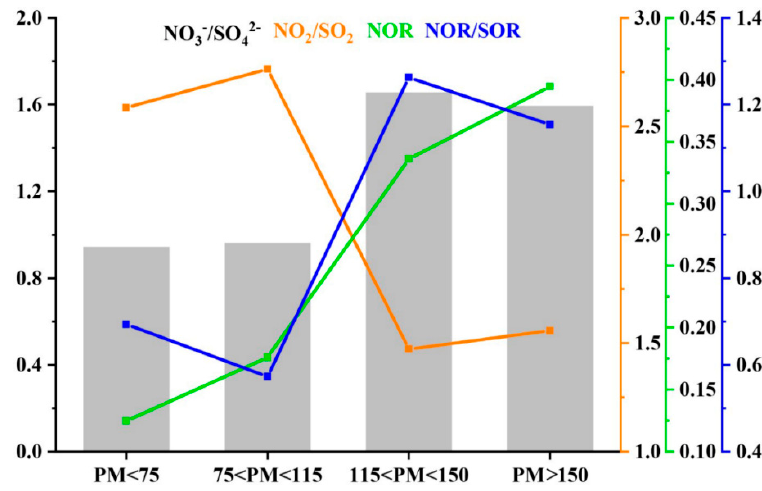
Figure 8. NO 3 − /SO 42 − ratio, NO 2 /SO 2 ratio, NOR and NOR/SOR ratio at different range of PM 2.5. Nitrate is predominantly formed by the homogenous reaction of NO 2 and OH radical during daytime and by heterogeneous hydrolysis of N 2 O 5 at night. Generally, the molar ratio [NH 4+ ]/[SO 42 − ] was used to assess NH 4+ rich conditions. As shown in Figure 9a,c,e, the intercept of [NH 4+ ]/[SO 42 − ] axis in linear regression models was 2.311 during the whole studied period, indicating that nitrate formation by homogeneous reactions of HNO 3 with NH 3 became significant at [NH 4+ ]/[SO 42 − ] > 2.311. Thus, the “excess ammonium” were defined as [NH 4+ ] excess = ([NH 4+ ]/[SO 42 − ] − 2.311) × [SO 42 − ] for the whole studied periods, [NH 4+ ] excess = ([NH 4+ ]/[SO 42 − ]– 3.162) × [SO 42 − ] for haze episodes, and[NH 4+ ] excess =([NH 4+ ]/[SO 42 − ] − 1.979) × [SO 42 − ] for non-haze episodes. The slope of 0.648 for the regression and the scattering of the data of the whole studied periods indicated that in PM 2.5 there was approximately 35.2% excess ammonium bounded with such anions − − as Cl and HSO 4 . Consequently, the higher slope during haze suggest that there was large amount of nitrate and sulfate in particles during haze. During the whole sampling period and non-haze periods, the concentration of excess ammonium was < 0 and showed significantly linear correlation with nitrate, indicating the formation of nitrate was strongly associated with ammonium. Namely, the pathway of nitrate formation is through the homogenous reaction of NO 2 . While during haze pollution, the excess ammonium was above 0, implying that gas-phase of NO 2 oxidation was decreased due to the low solar radiation and the heterogeneous formation of nitrate became